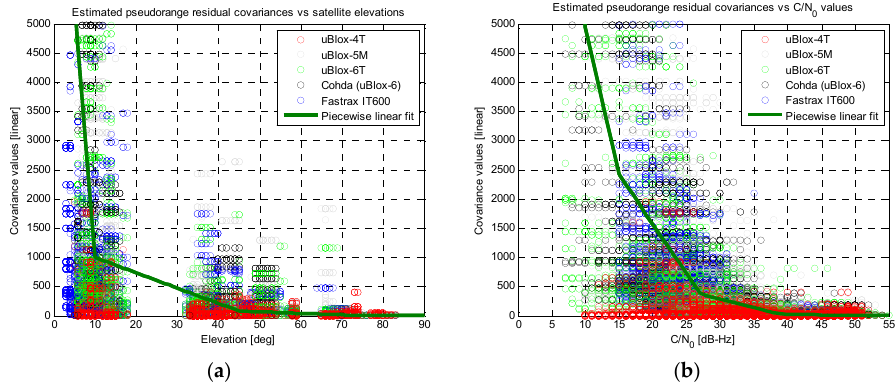
Figure 8. Results of the linear fitting for the covariance of the residuals (linear scale on vertical axes): ( a ) versus satellite elevations; ( b ) versus C/N 0 measurements.